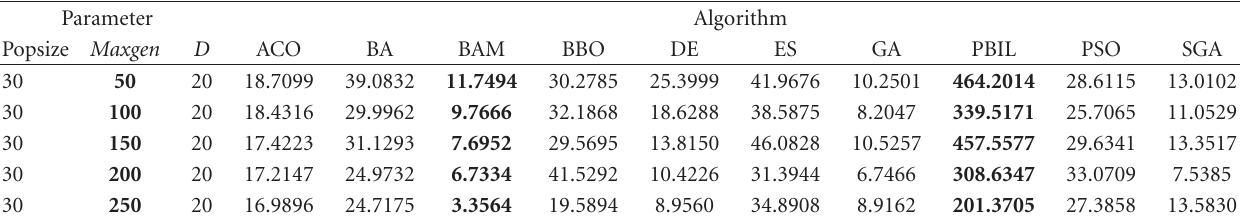
Table 3: Worst normalized optimization results on UCAV path planning problem on di ff erent Maxgen . The numbers shown are the worst results found after 100 Monte Carlo simulations of each